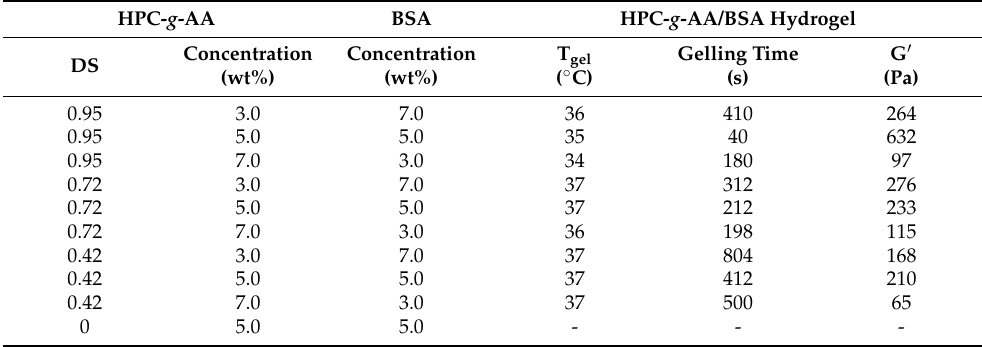
Table 3. The sol/gel transition temperature and gelling time at 37 ◦ C of HPC- g -AA/BSA hydrogel as a function of HPC- g -AA DS, HPC- g -AA concentration, and BSA